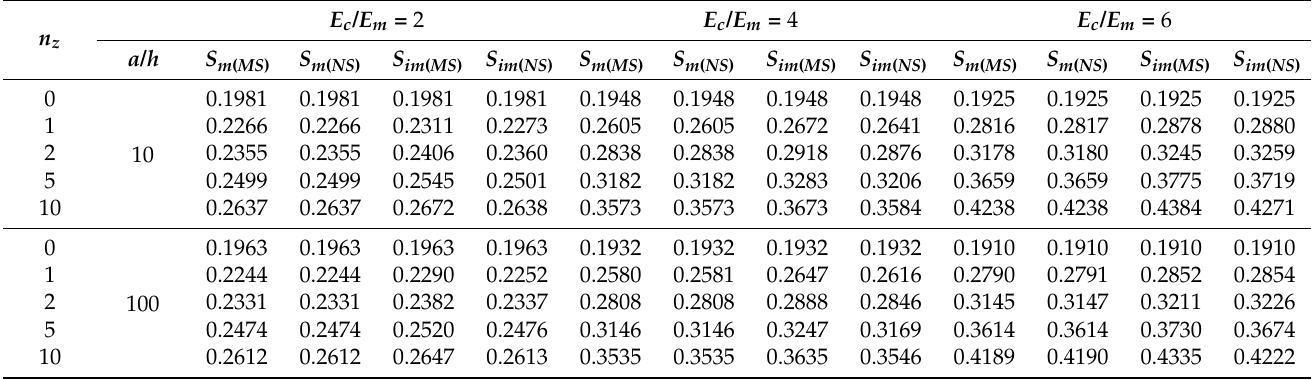
Table 6. Non-dimensional axial stress σ x of BDFG square movable ( m ) and immovable ( im ) simply supported plates subjected to bi-sinusoidal load based on middle surface formulation ( MS ) and